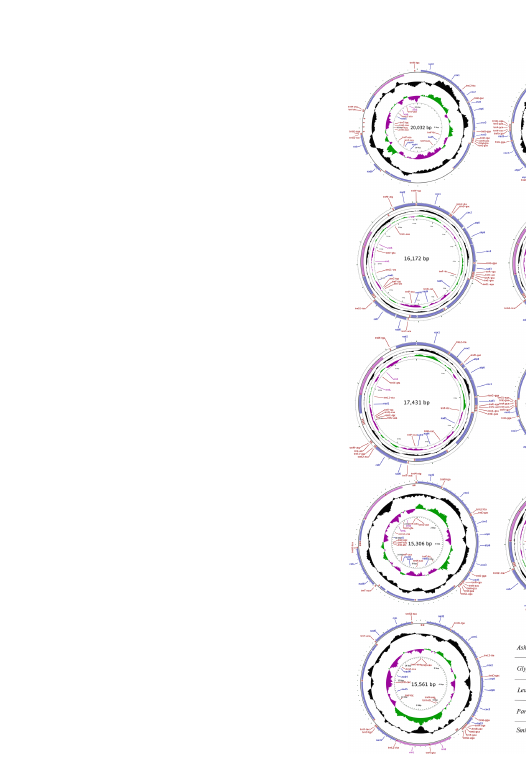
FIGURE 1 The organization of the mitogenomes of the newly sequenced specimens used in this study.